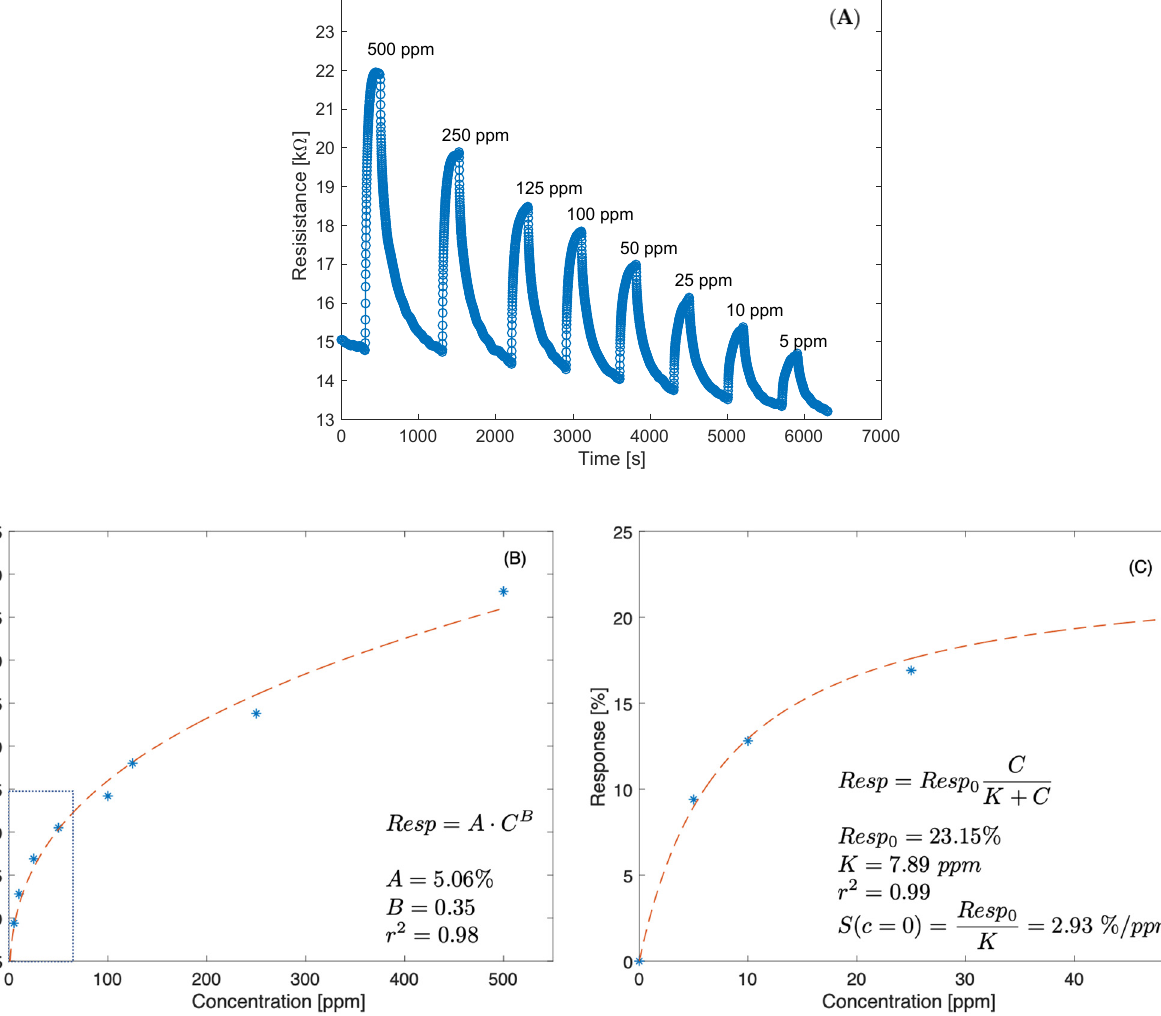
Figure 11. ( A ) Dynamic resistance of the sensor at room temperature and 45% relative humidity towards different NH 3 concentrations. ( B ) Sensor response curve as a function of the ammonia concentration. Freundlich isotherm fit is also shown (red dashed line). ( C ) Sensor response in the range 0–50 ppm of ammonia fitted by a Langmuir isotherm function. The sensitivity at the origin is calculated as the derivative of the Langmuir function in c = 0 ppm.